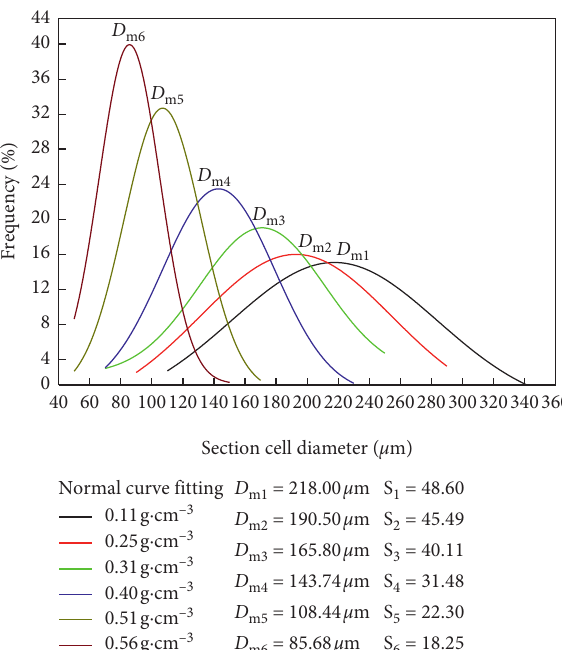
Figure 7: Summary of the section cell diameter distribution ( D deviations).